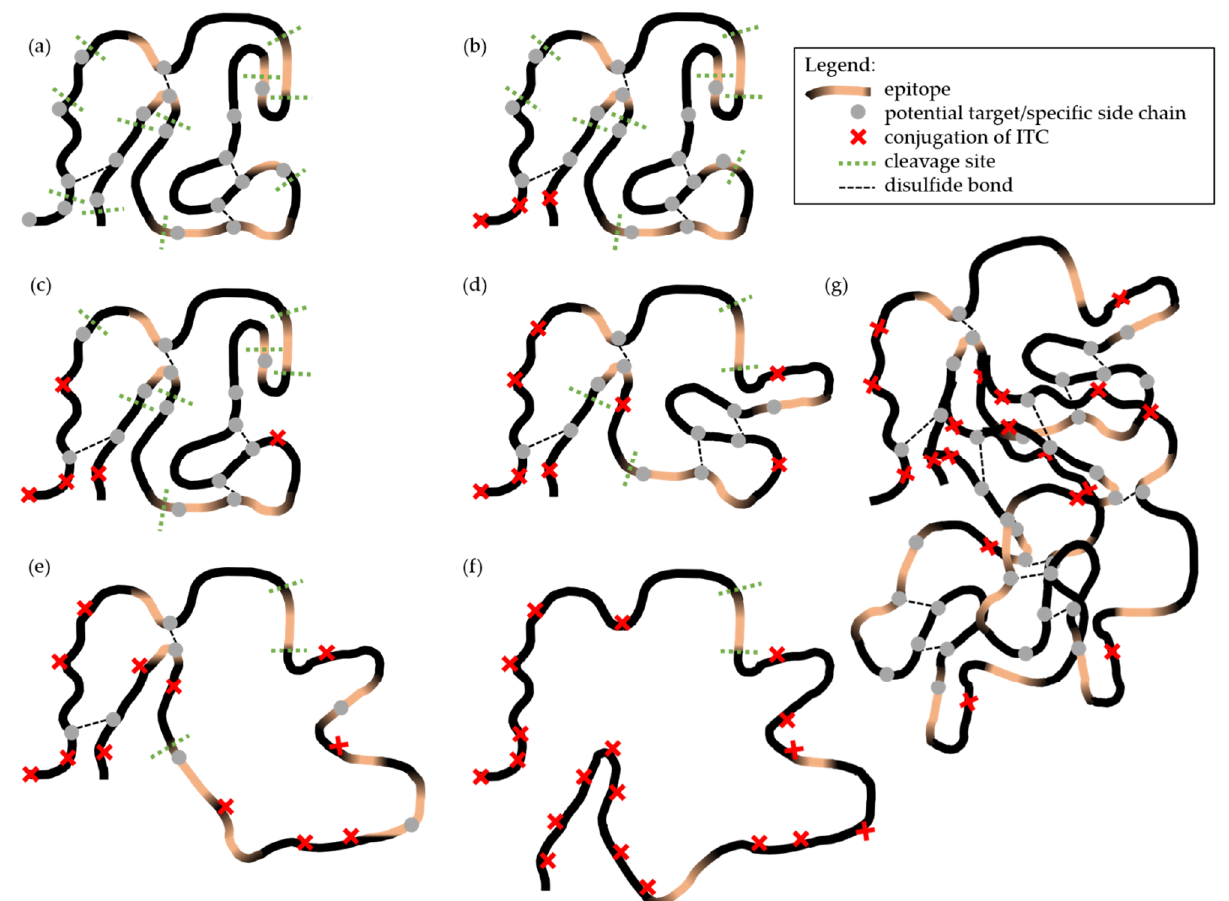
Figure 4. Schematic illustration of the influence of a protein modification on protein structure, epitopes, and enzymatic hydrolysis. While potential reaction sites for the ITC are represented by gray dots, ITC conjugation is highlighted by the red crosses. Intact epitopes are shown as orange regions, tryptic cleavage sites by green dashed lines, and disulfide bridges by black dashed lines. ( a ) Native protein with the potential reaction sites for ITC and its intact epitopes; ( b – g ) increasing degree of protein modification and the resulting change in protein structure, epitope, and enzymatic hydrolysis. The protein structure, locations of epitopes, disulfide bridges, and tryptic cleavage sites are not realistically depicted.